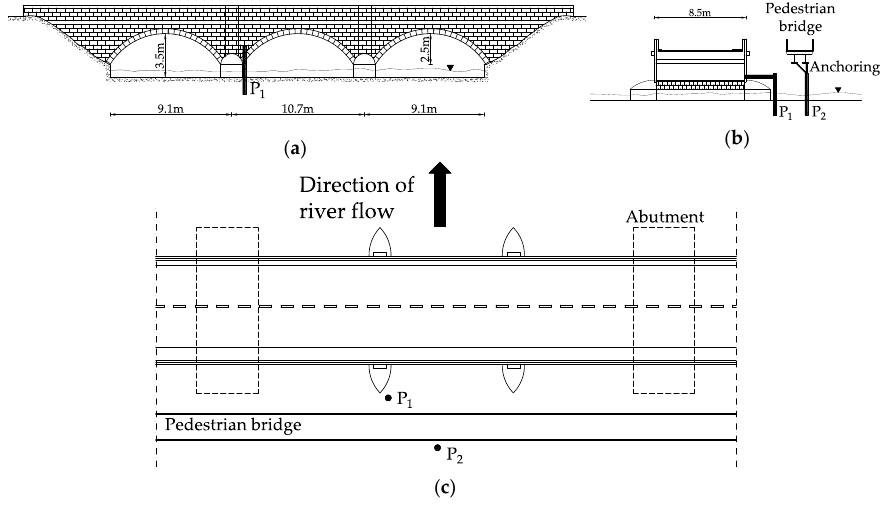
Figure 14. Layout of the pilot scour monitoring system. ( a ) Side view; ( b ) Section view; ( c ) Plan view.